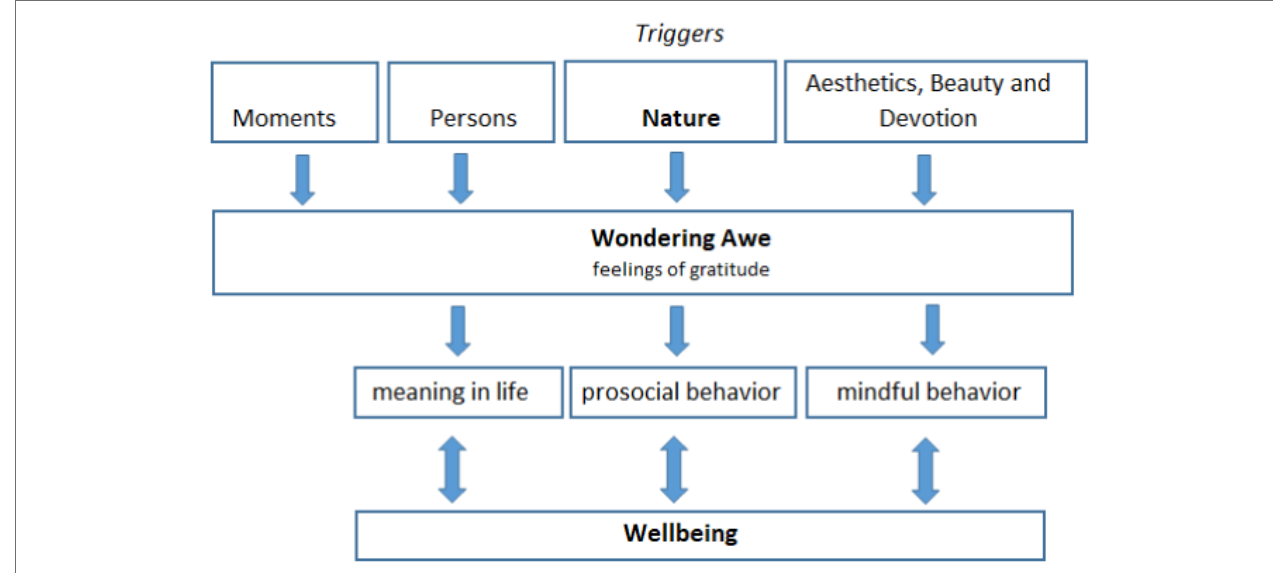
FIGURE 3 | Putative pathways of awe triggers and related